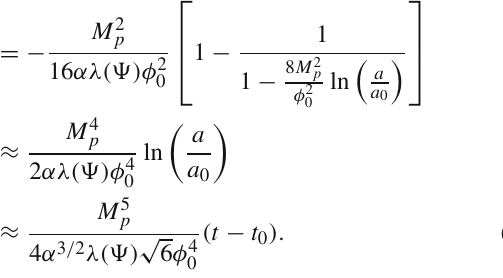
Fig. 2 Behavior of the inflationary potential for a V 0 ≈ 0 and λ > 0 (Case I) and b V 0 (cid:11)= 0 and λ < 0 (Case II). In a the inflaton rolls down from a large field value and inflation ends at φ f ≈ 1 . 09 M p . On the other hand in b the inflaton field rolls down from a small field value